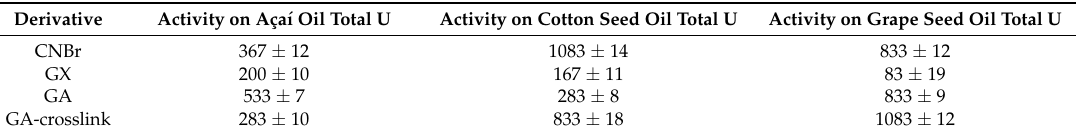
Table 3. Hydrolysis of açaí, cotton seed and grape seed oils catalyzed by the derivatives of H. pseudokoningii lipase.